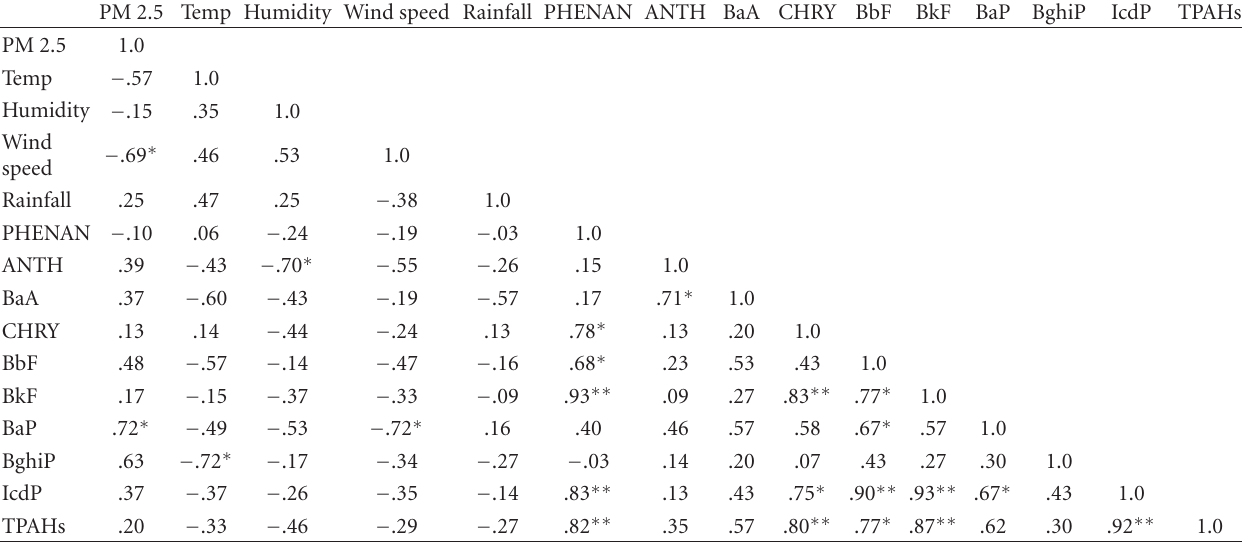
Table 4: Correlation between meteorological parameters and PAH.